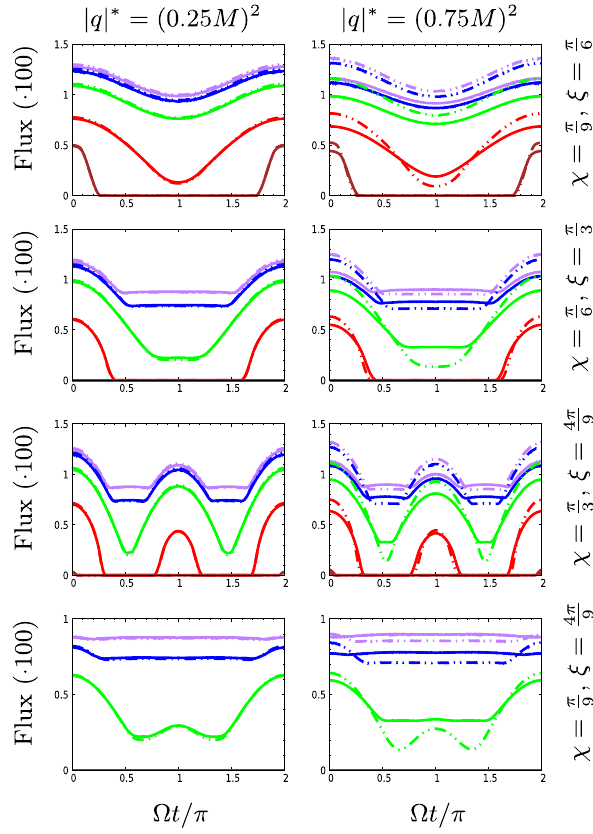
Fig. 29 Pulse profile for antipodal caps. h = 2, R / r h = 3. Purple, blue, green, green, red and brown lines correspond to (cid:11) = 0 . 00, 0 . 30, 0 . 60, 0 . 90 and 0 . 99 respectively. The solid lines correspond to q ∗ > 0 while the dashed lines correspond to q ∗ <